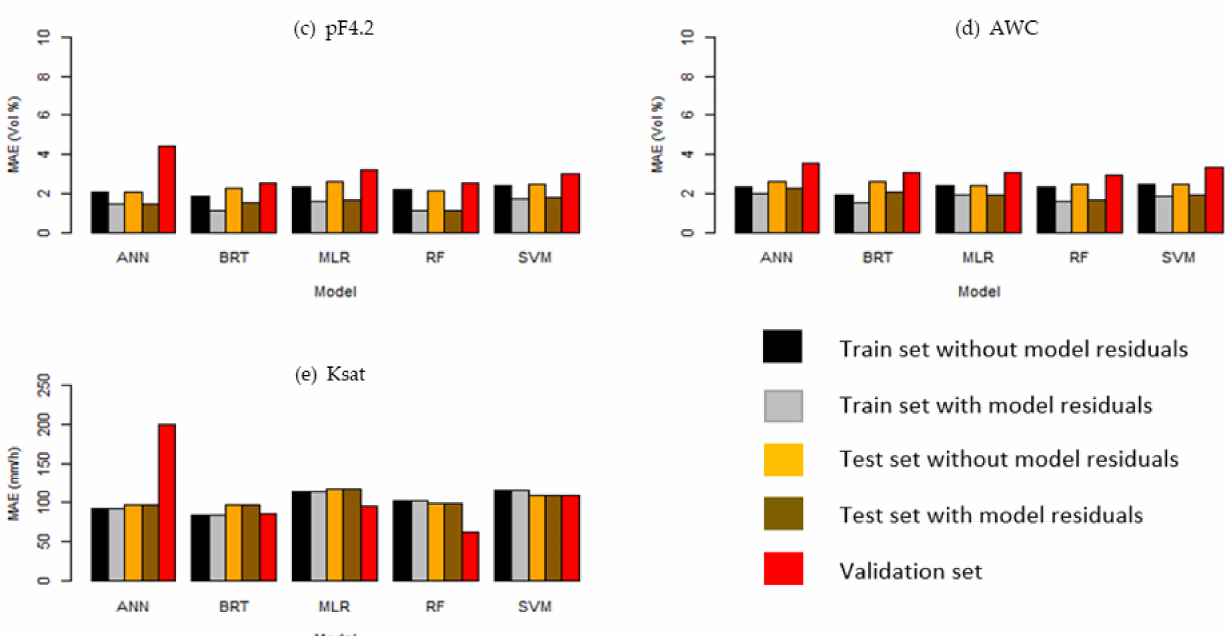
Figure 8. Mean absolute error (MAE) for the five DSM models applied to the training sets without residuals (black), training sets with residuals (grey), test sets without residuals (orange), test sets with residuals (brown), and the validation data sets (red). ANN, artificial neural network; BRT, gradient boosted regression trees; MLR, multiple linear regression; RF, random forest; SVM, support vector machine. Panel ( a ) shows the response variable pF0.0, panel ( b ) for pF2.0, panel ( c ) for pF4.2, panel ( d ) for AWC and panel ( e ) for Ksat at a depth of 30 cm.